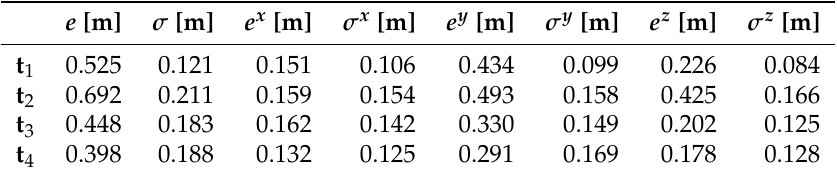
Table 2. Experimental results in Configuration 2: measured average errors ( e , e x , e y , and e z ) are shown together with the relative standard deviations ( σ , σ x , σ y , and σ z ) for the four considered positions ( t 1 , t 2 , t 3 , and t 4 ) of the TN.